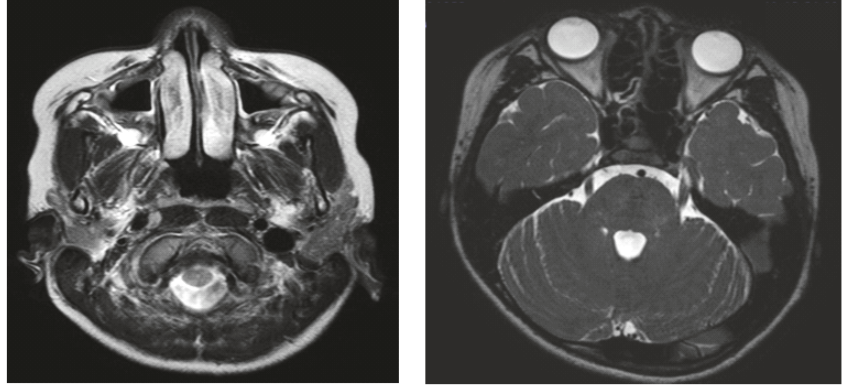
Figure 1: Head imaging study. Head computed tomography showed mucous membraneswelling and fluid collection in both maximal sinuses (left). Brain magnetic resonance image. Vascular compression of the trigeminal nerve was not observed